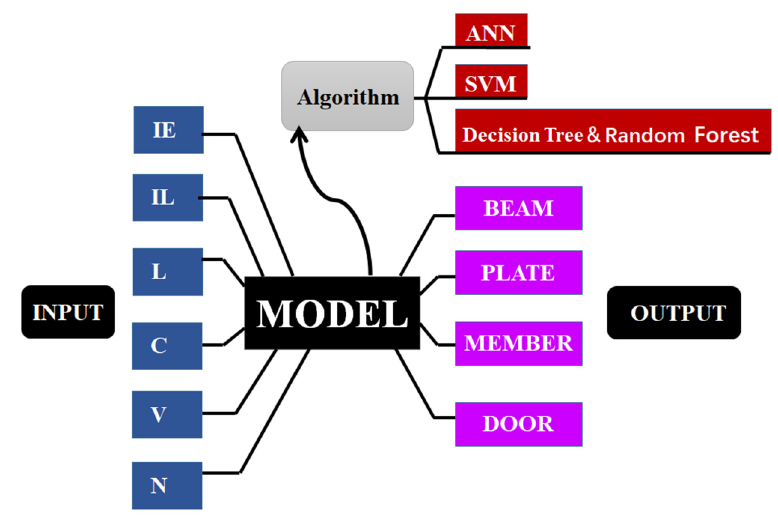
Figure 6. The overall idea of BIM element classification.